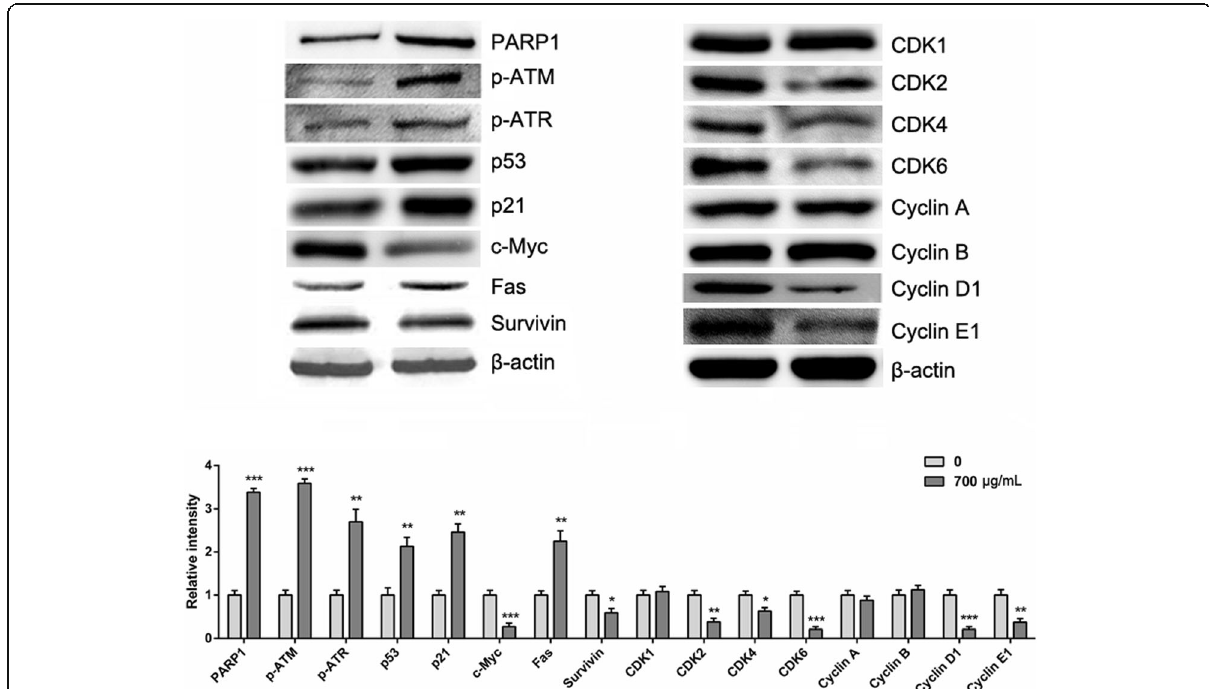
Fig. 4 Apoptosis related protein expression was detected by western blot analysis after treatment of the CTC-TJH-01 cells with Jinfukang (0, 350, 700 μ g/mL) for 48 h. β -actin was used as an internal